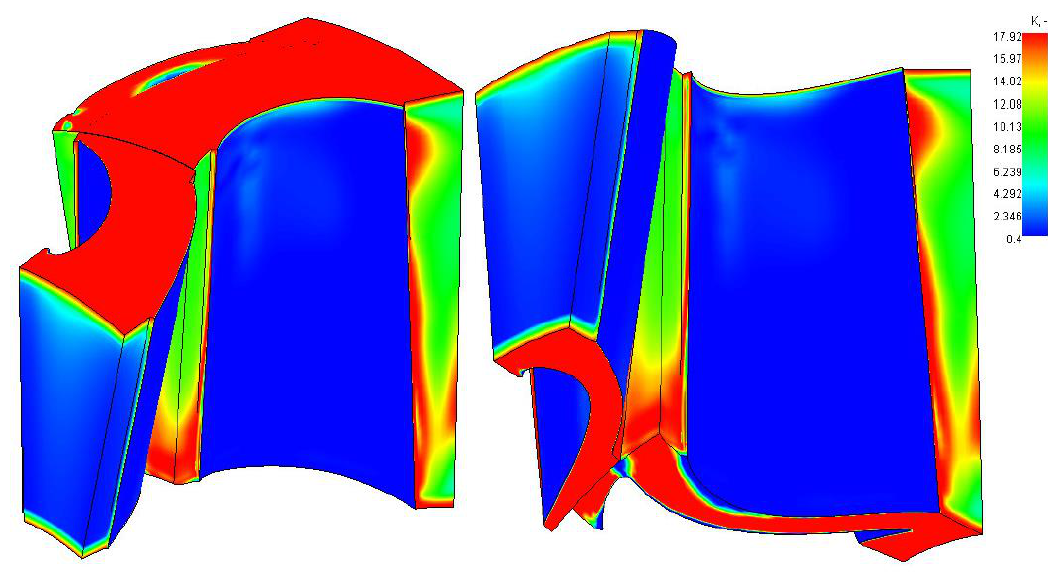
Figure 38. Wall surface turbulent kinetic energy scenes.